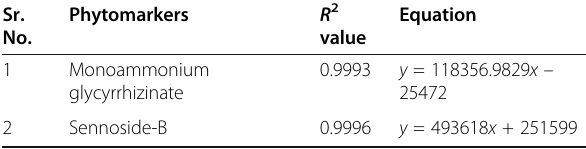
Table 7 Intra-day and inter-day precision